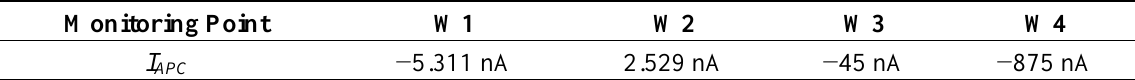
Table 3. Anodic polarization current of monitoring points.